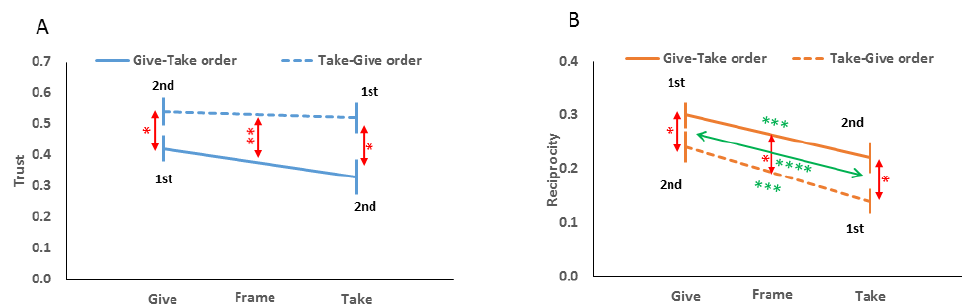
Figure 2. Impact of order on framing of trust and reciprocity. ( A ). Trust. An order effect was observed for trust with higher trust in Take-Give (T-G) than Give-Take (G-T) order. Trust was higher in the first than the second decision for the Take-Frame (T-Frame) but lower in the first than the second decision for the Give-Frame (G-Frame) due to an anchoring bias. Framing within each order disappeared due to strong anchoring to the first decisions. ( B ). Reciprocity. An order effect was detected with higher reciprocity in the G-T than T-G order. Reciprocity was lower in the first than second decision for the T-Frame but higher in the first than second decision for the G-Frame due to an anchoring bias. Framing within each order did not disappear due to weak anchoring to the first decisions. * p < 0.05, ** p < 0.01, *** p < 0.005, **** p < 0.001, red color: order effect, green color: framing